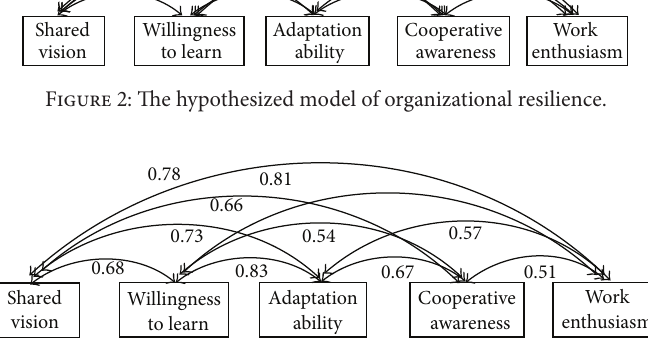
Figure 3: The structure model of organizational resilience.